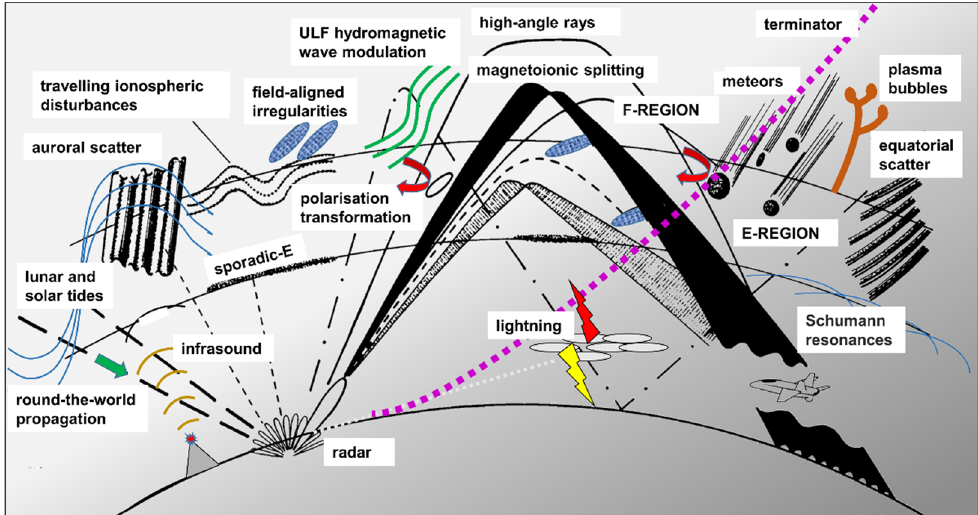
Figure 2. Common ionospheric phenomena that impact HF radar.